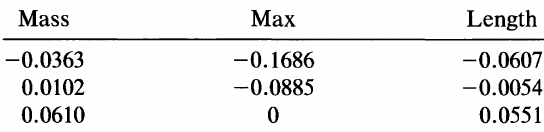
Table 2. Derivatives of First Eigenvector With Different Normalization